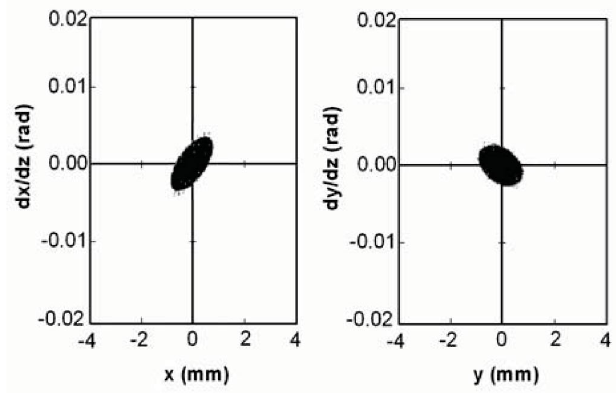
FIG. 9. Phase portrait in front of